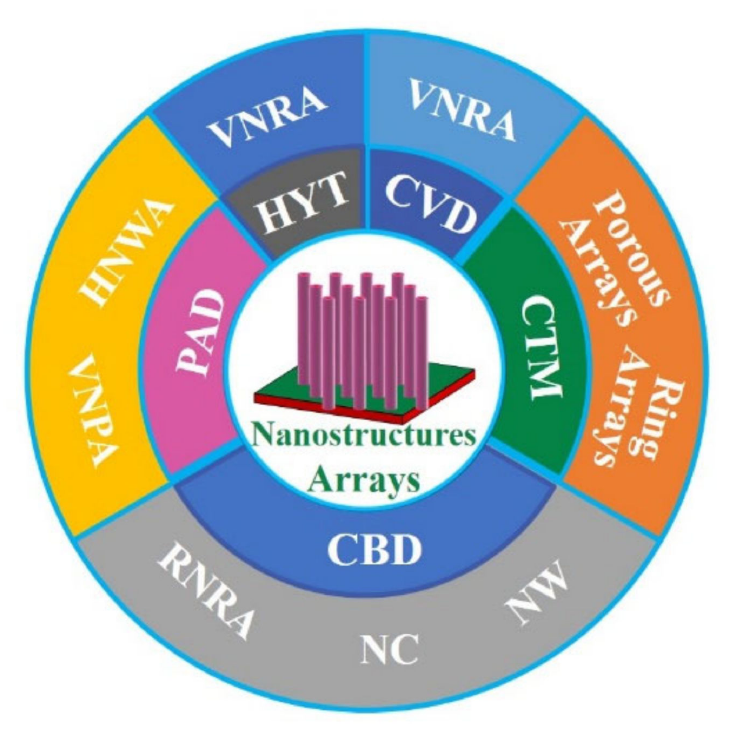
Figure 5. ZnO nanostructure